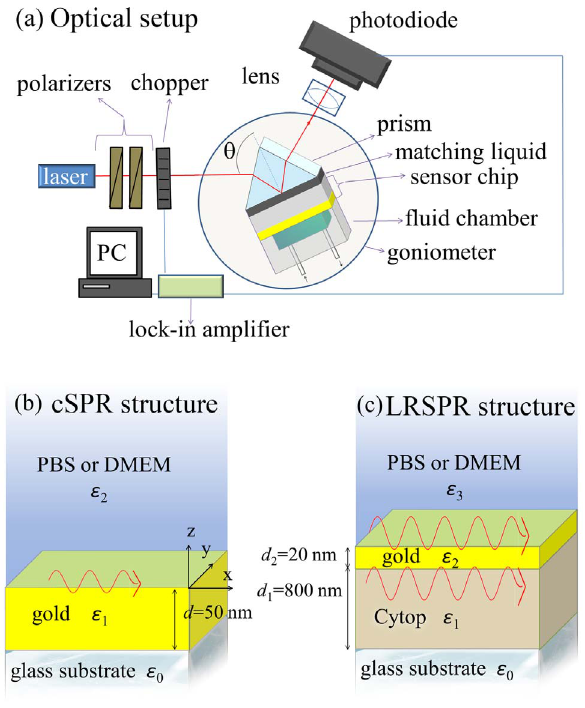
Figure 1. Experimental setup. (a) Scheme of the instrument set for angular interrogation of SPR sensors utilizing the attenuated total internal reflection method. Two different SPR structures with different characteristic propagation and penetration lengths were used in this study: (b) cSPR is composed of a layer of gold comprised between the glass substrate (prism) and the cover medium (PBS or DMEM plus cells) and (c) LRSPR is composed of a layer of Cytop polymer deposited on the glass substrate, onto which a thin layer of gold is sputtered, creating a RI symmetry supporting long range plasmon waves.